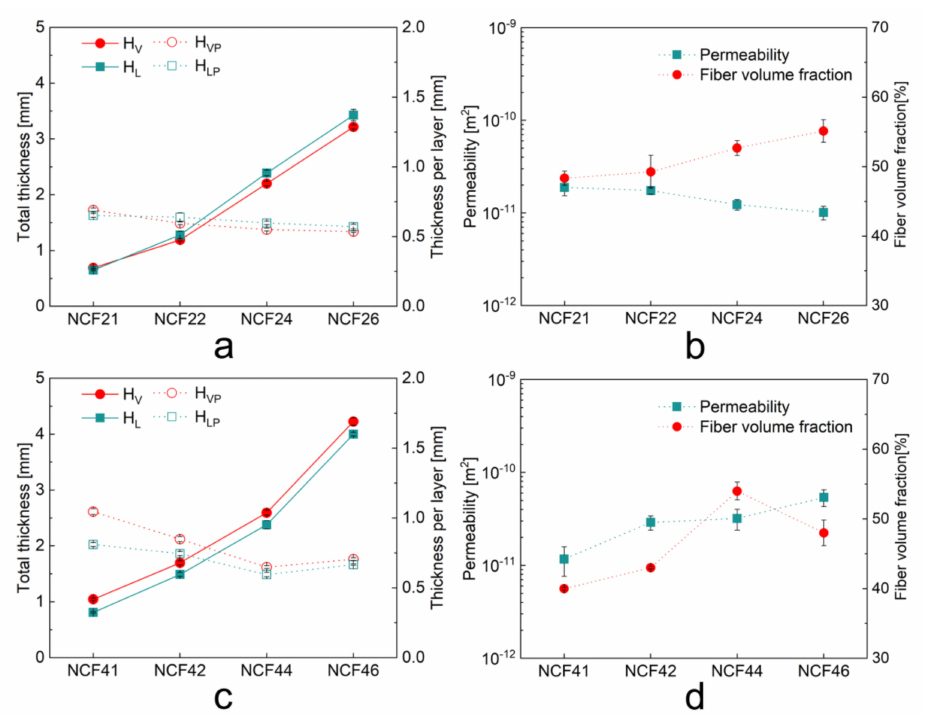
Figure 3. ( a ) Total thicknesses and average layer thicknesses of the biaxial preforms at varied compaction states; ( b ) unidirectional permeability and fiber volume fraction of biaxial preforms with di ff erent numbers of layers; ( c ) total thicknesses and average layer thicknesses of the quadriaxial preforms at varied compaction states; ( d ) unidirectional permeability and fiber volume fraction of quadriaxial preforms with di ff erent numbers of